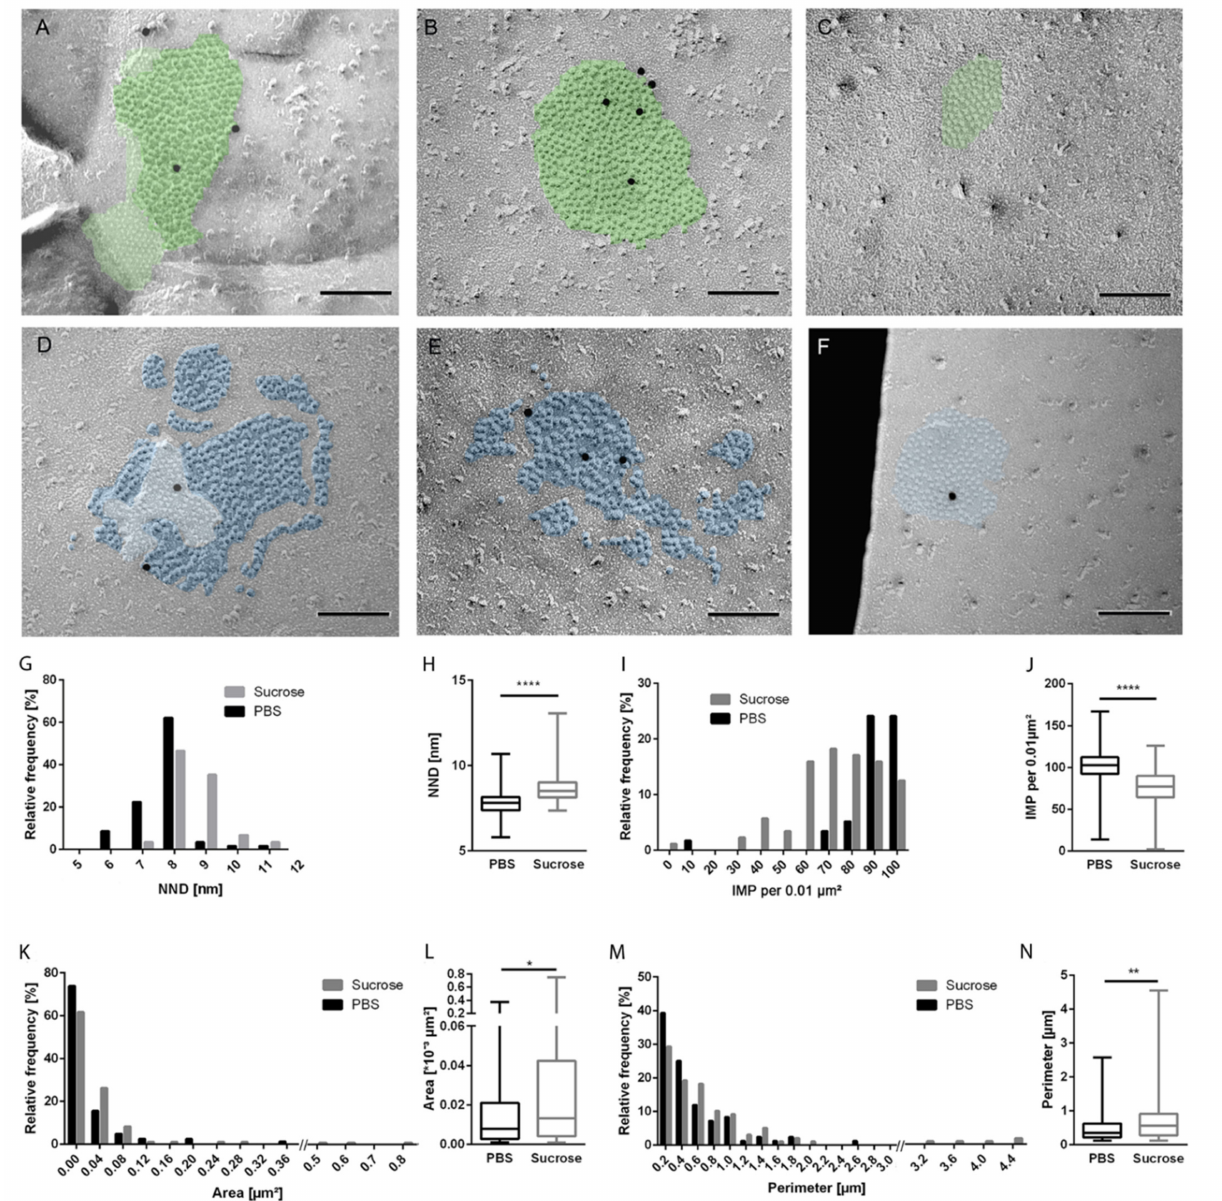
Figure 1. Sucrose loosened up the connexon arrangement within gap junction plaques. Astrocytic membranes were freeze-fractured and replicated after treatment with sucrose or incubation with PBS as a control. Replicas were labeled with primary antibodies against the C-terminus of Connexin (Cx) 43 and gold-conjugated secondary antibodies (black dots represent 12 nm gold). ( A – C ) Intramembrane particles (IMPs) in gap junctions of control cells appeared regularly arranged, and gap junctions featured both extraplasmic (E)– and protoplasmic (P)–faces ( A ) (pits are overlaid in light green and particles in darker green), P-faces only ( B ), or E-faces only ( C ). After sucrose treatment, the gap junction formation looked less compact and the IMP arrangement appeared dispersed on both E- and P-faces ( D ), pits with light blue overlay and particles in darker blue), only P-face ( E ) or only E-face ( F ). Quantification of freeze-fracture-replica immunolabeling (FRIL) data confirmed those observed changes. Histograms displaying the relative frequencies of ( G ) the distance between nearest neighbors, ( I ) the number of IMPs per area, ( K ) the gap junction area, as well as ( M ) the perimeter showed a clear shift upon sucrose treatment. Sucrose caused enlargement of the gap junction plaque without integration of new IMPs, as the number of IMPs per 0.01 µ m 2 decreased, resulting in a shift to the left for sucrose-treated gap junctions ( I ). Those changes between gap junctions of control cells and sucrose-treated cells were significantly different ( H , J , L , N ). Statistical data were presented in box plots showing the median with whiskers for minimum and maximum. Statistic significances indicated in the figure are: * p <0.05, ** p <0.01, and **** p < 0.0001. Scale bars in ( A – F ) represent 100 nm. Adapted from